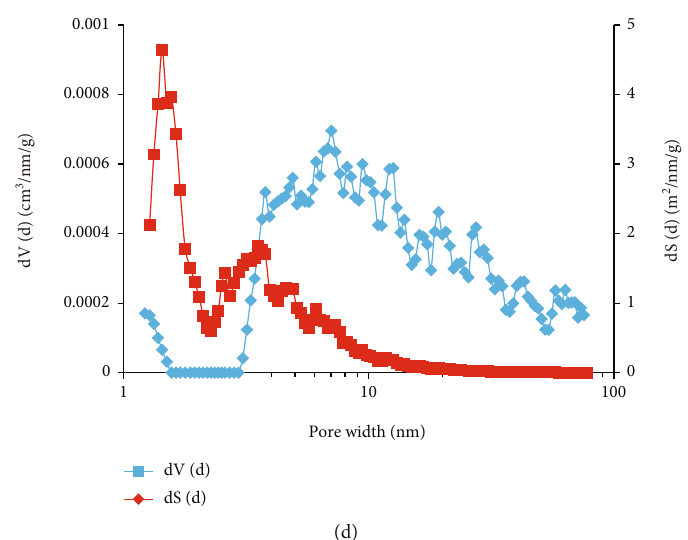
Figure 3: Typical sample N adsorption-desorption isotherms and pore size distribution of samples. 2 Table 2: Pore types obtained from the adsorption isotherms using N Loop